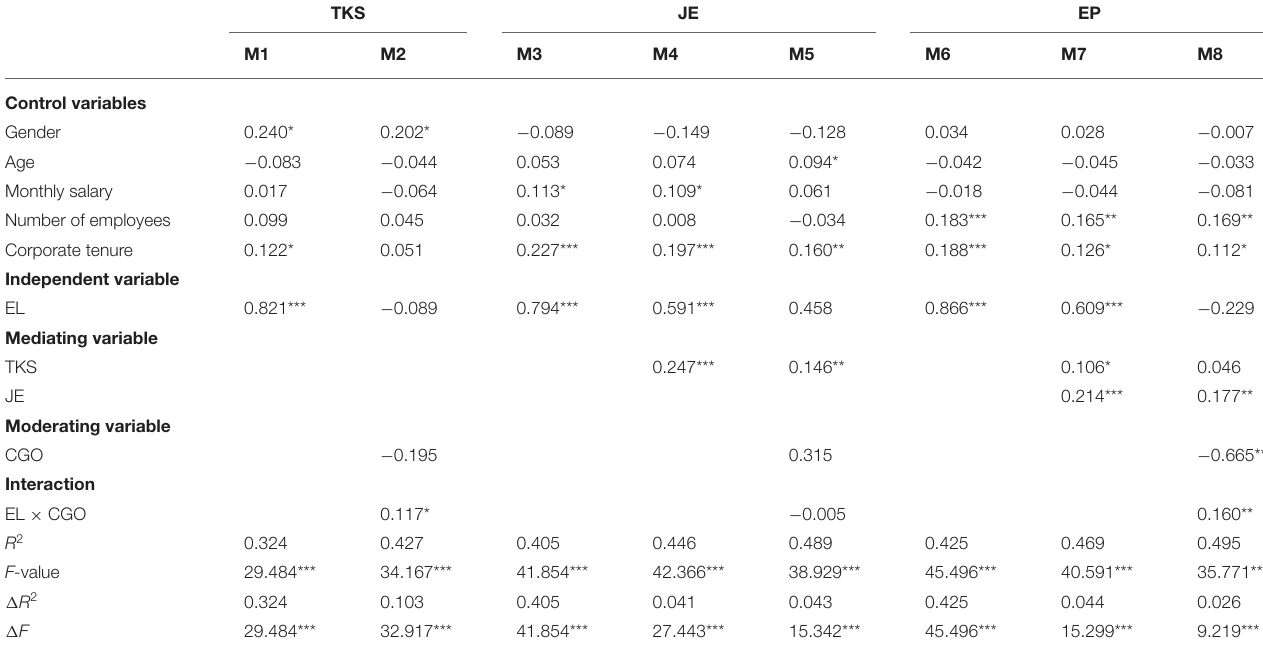
TABLE 3 | Hypothesis test results.